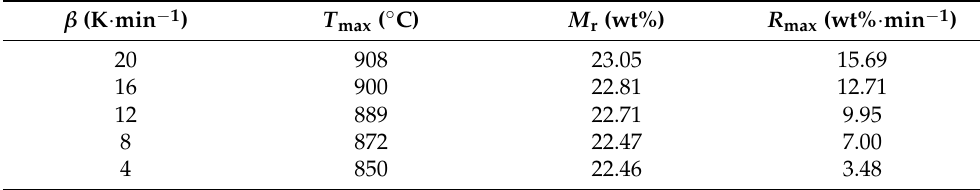
Figure 1. Thermal analyses of the gasification of the char sample derived from the NX coal source at different heating rates: ( a ) TGA; ( b ) DTG. Table 2. Characteristic parameters of the steam gasification of char derived from Figure 1 at different heating rates β . The parameters include the temperature, corresponding to the weight loss peak ( T max ), the ultimate weight loss during char gasification ( M r ), and the maximum rate of weight loss ( R max ).